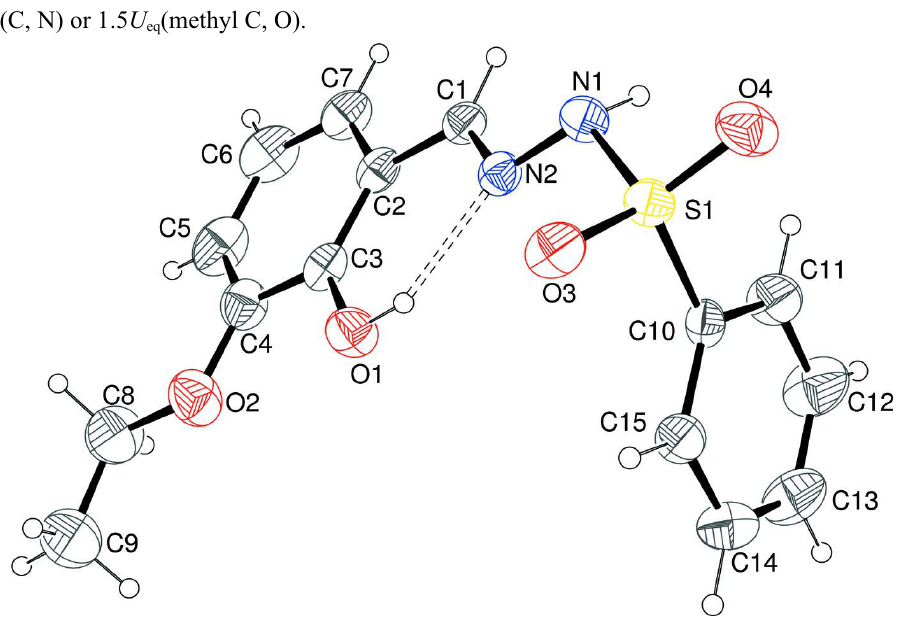
The C1-containing molecule in (I) showing 30% displacement ellipsoids for the non-hydrogen atoms. The intramolecular hydrogen bond is indicated by a double-dashed